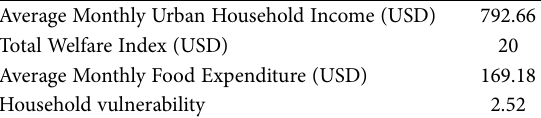
Table 4. Vulnerability index.